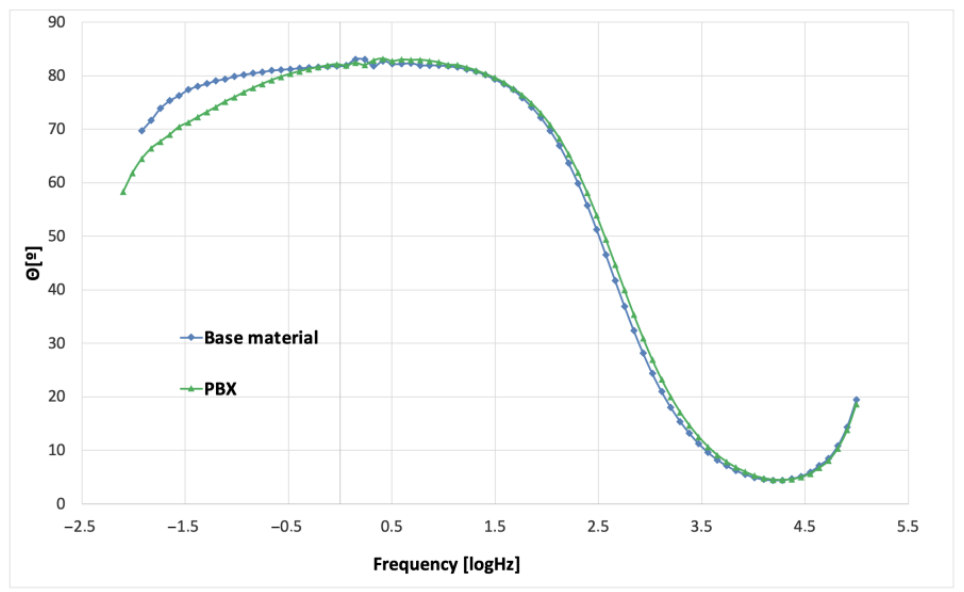
Figure 15. Bode summary plot for the phase angle values for the tested samples.